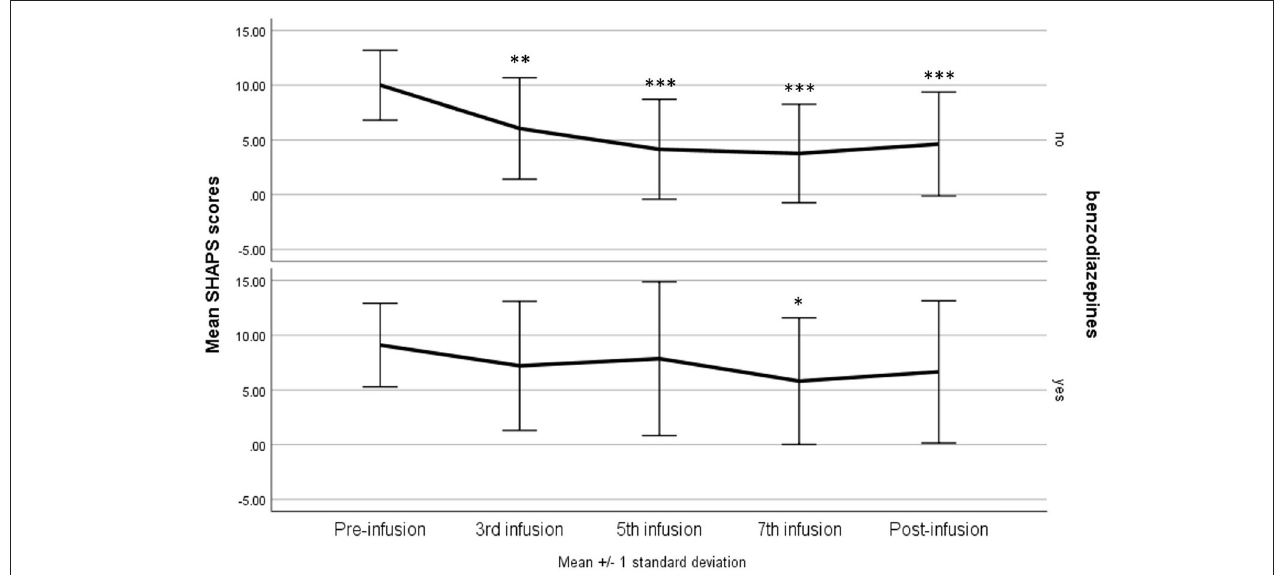
FIGURE 3 | The 30-item inventory for Depressive Symptomatology—Self Report (IDS-SR 30) score during ketamine treatment. * p < 0.05, *** p < 0.001 in comparison with baseline scores (pre-infusion).